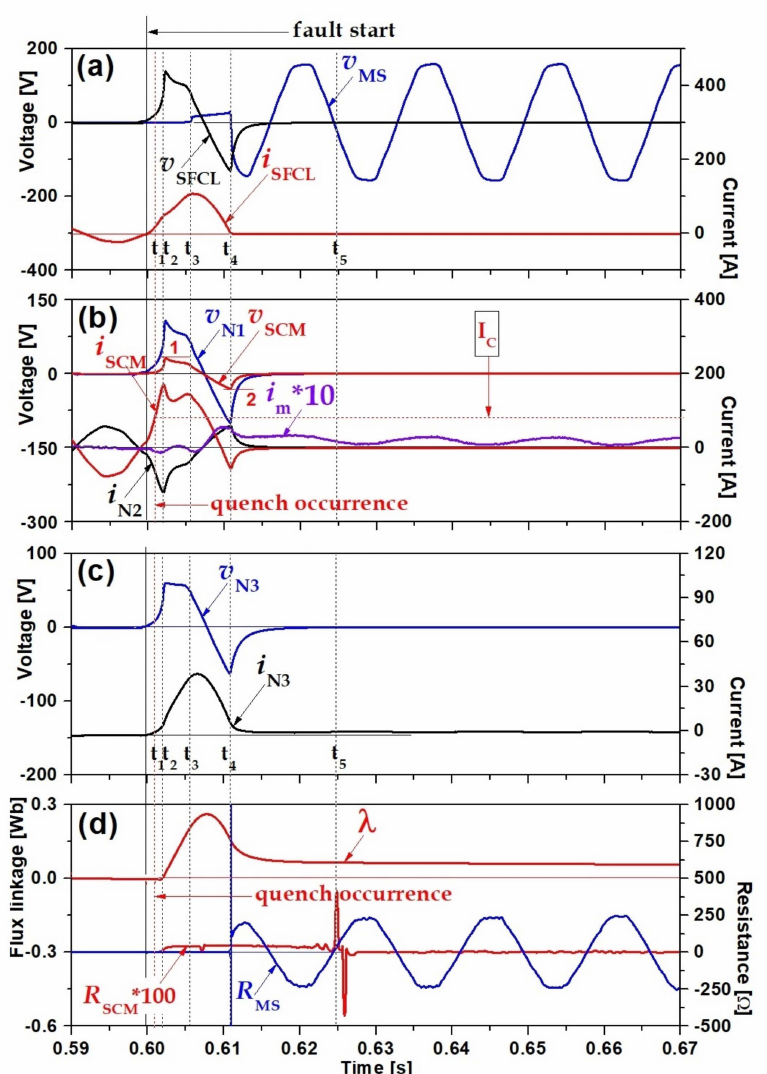
Figure 6. Fault current limiting and breaking operational waveforms of the SFCLB using flux coupling with a tap changer in the case of a series connection. ( a ) Voltages of MS and SFCL ( v MS , v SFCL ), current of MS ( i MS = i SFCL ). ( b ) Voltages of coil N 1 and SCM ( v N1 , v SCM ), currents of coil N 2 , SCM and magnetizing branch ( i N2 , i SCM , i m ). ( c ) Voltage of coil N 3 ( v N3 ) and current of coil N 3 ( i N3 ). ( d ) Flux linkage ( λ ) and resistance of SCM and MS ( R SCM , R MS